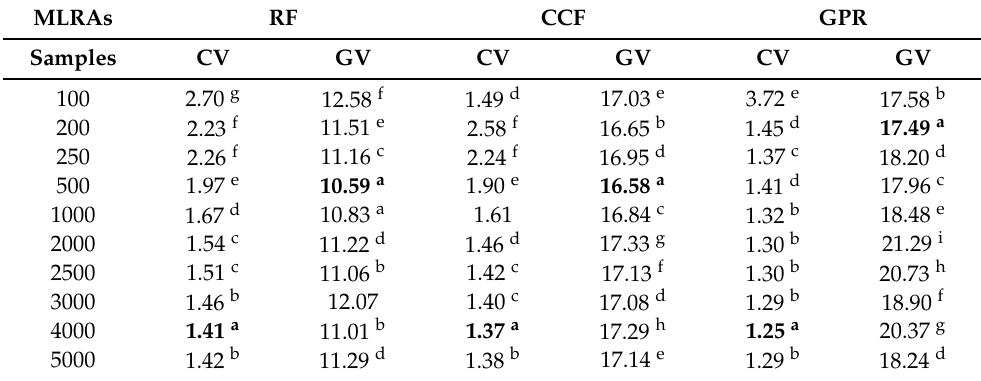
Table A3. Average NRMSE % of 10 replicates, based on cross-validation and ground validation under different sample sizes and machine learning methods, for fCover estimates.